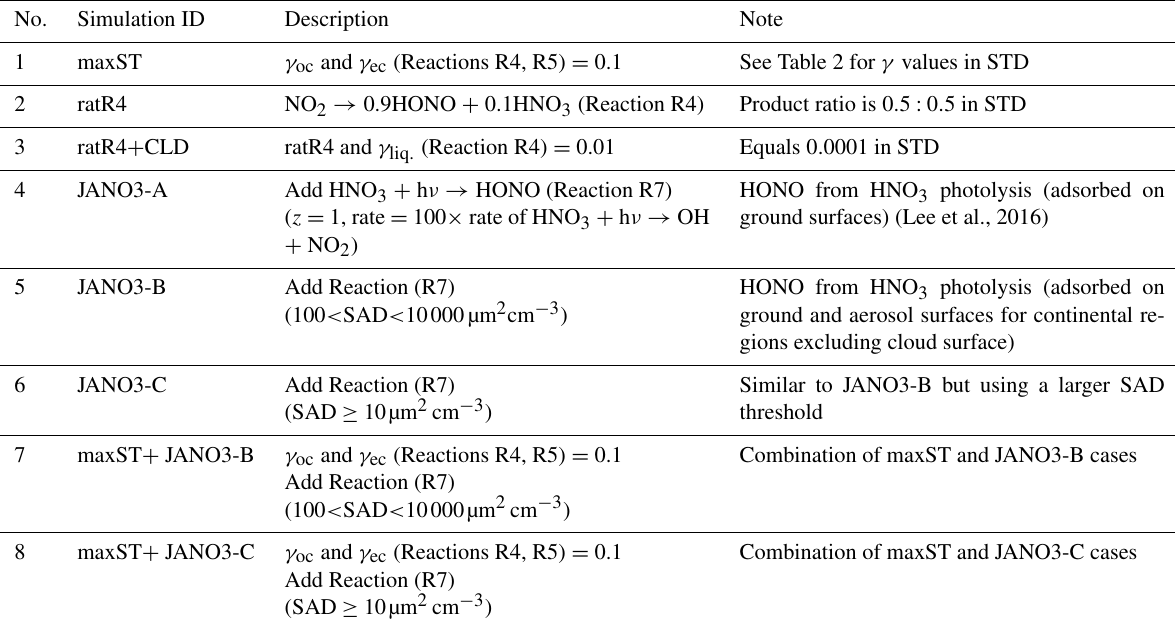
Table 5. Additional sensitivity simulations in this